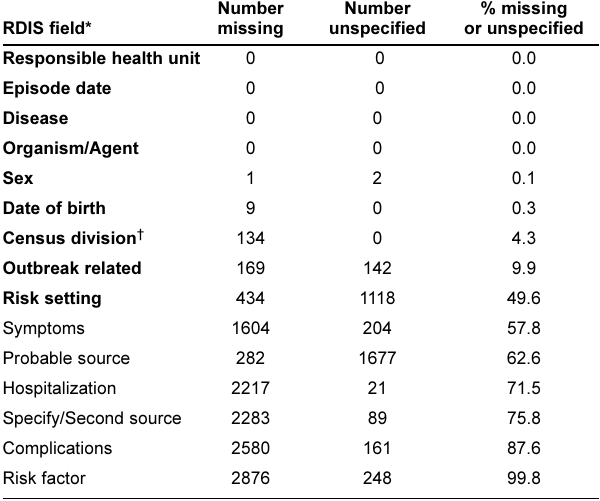
TABLE 1 Frequency distribution of missing or unspecified values of fields of cases of Salmonella serotype typhimurium infections reported in Ontario from 1990 to 1997 (n=3129)